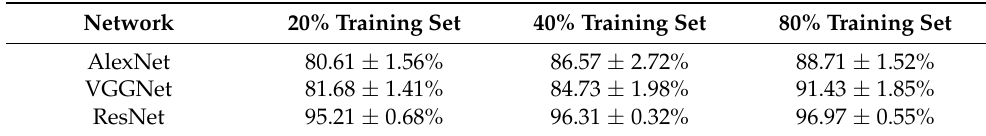
Table 5. Accuracy results for the NWPU-RESISC45 data sets after adding data generated by our method.